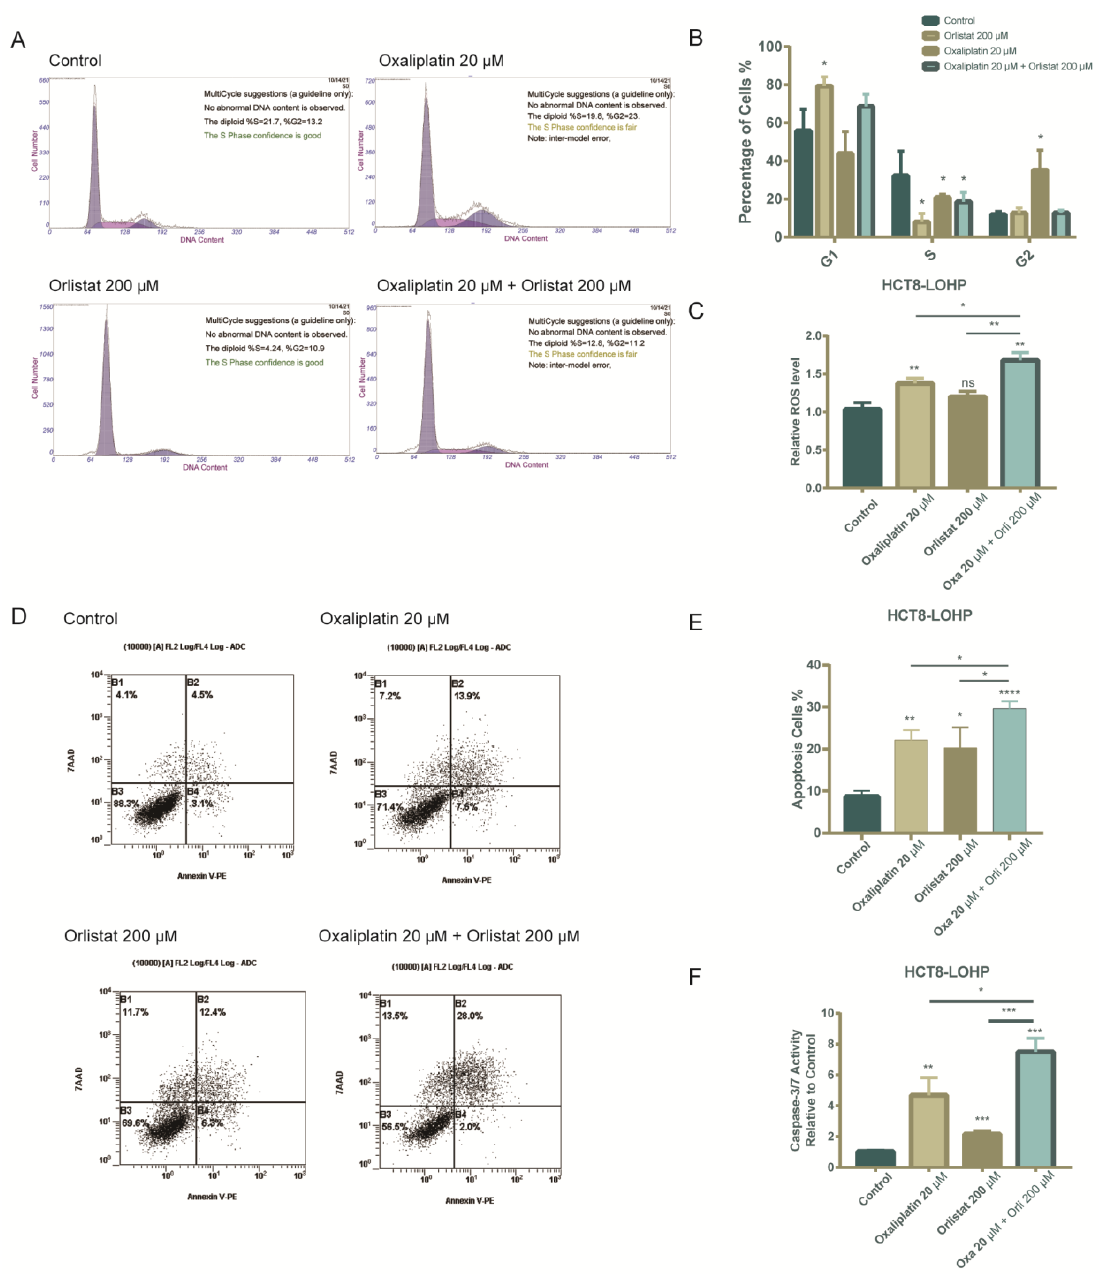
Figure 4. Oxaliplatin combined with Orlistat induced cell-cycle arrest and increased ROS levels and apoptosis in HCT8-LOHP cell lines. ( A , B ) Cell-cycle analysis by flow cytometry indicated that treatment with oxaliplatin, Orlistat, and drug combination led to G1 arrest. Additionally, the change in each phase of cell cycle in each group was analyzed by one-way ANOVA with the Dunnett post hoc test. ( C ) Reactive oxygen species (ROS) was evaluated using the Reactive Oxygen Species Assay Kit (Beyotime). The result indicated that combination of Orlistat and oxaliplatin significantly increased ROS levels in HCT8-LOHP cell lines. ( D , E ) Apoptosis level, indicated by staining cells with Annexin V/7-AAD in each group in indicated treatments, was compared with control by one-way ANOVA with Dunnett ’s post hoc test, respectively. ( F ) Cellular caspase-3/7 activity was determined by the Caspase 3/7 Activity Apoptosis Assay Kit *Green Fluorescence (Sangon Biotech) and expressed relative to the control. Cells were treated for 72 h. Relative caspase activity upon indicated treatments was compared with the control by one-way ANOVA with Tukey ’s post hoc test. * p ≤ 0.05, ** p ≤ 0.01, *** p ≤ 0.001, **** p ≤ 0.0001, ns: no significance.